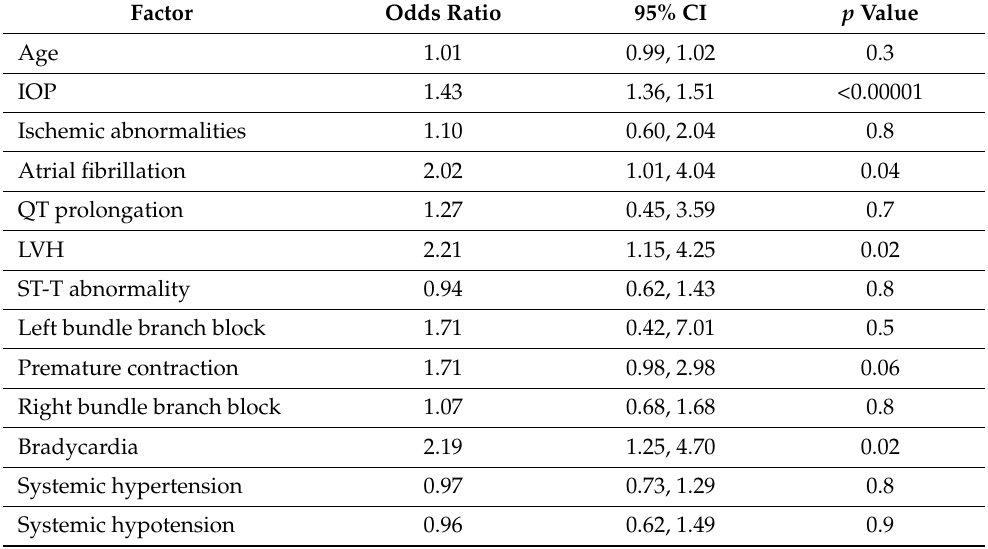
Table 2. Odds ratio of each factor related to glaucoma